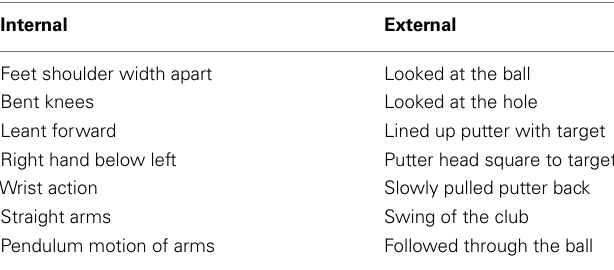
Pre-test, LA, and HA Table 1 | Episodic memories reported; categorized as internal or